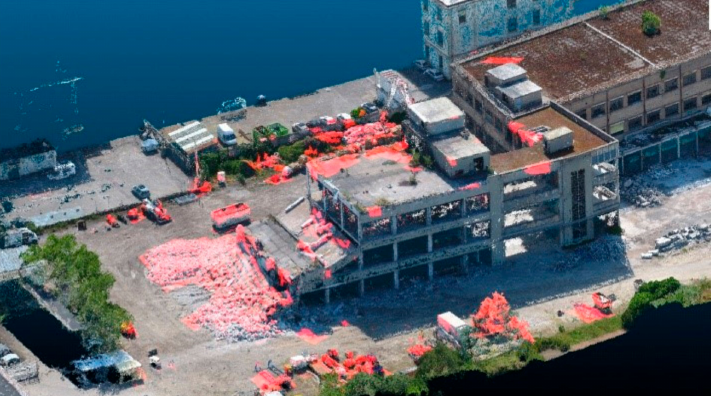
Figure 4. Point cloud representation of an INACHUS pilot structure in Lyon, France, calculated from optical imagery acquired with a low-cost commercial drone (Phantom 4, DJI), showing damage detected through machine learning (red).